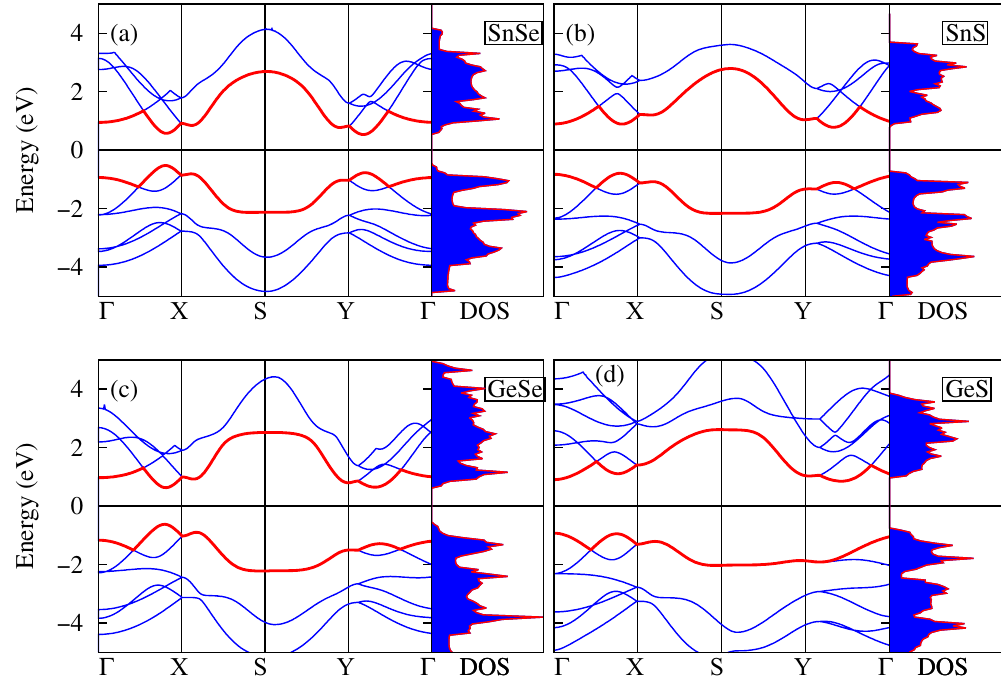
Figure 2. Band structures along the high-symmetry k -points Γ , X , S , and Y and density of states of ( a ) SnSe, ( b ) SnS, ( c ) GeSe, and ( d )